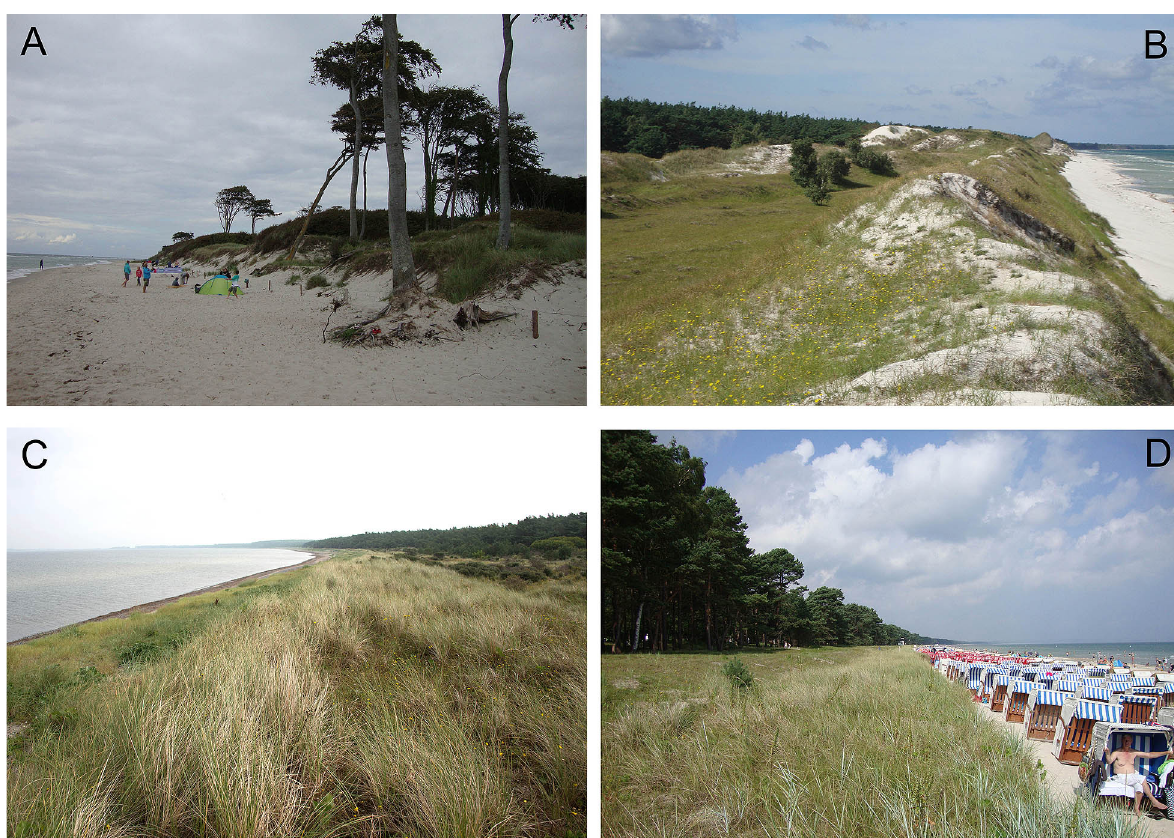
Fig. 3. Low dunes on bay and booden coast of Germany (Photo T. Łabuz ).